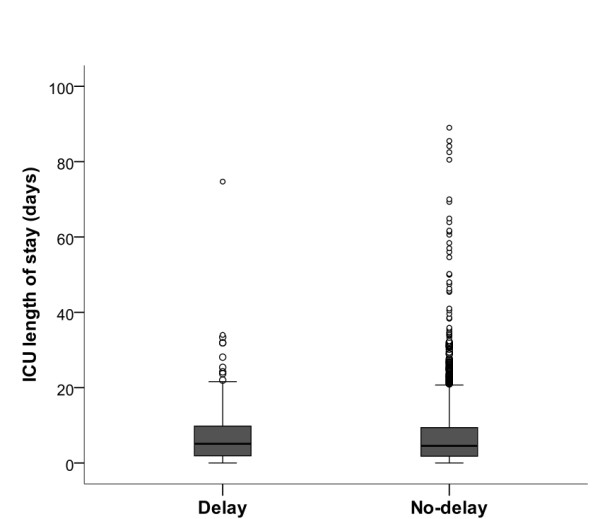
Length of ICU stay. Components: Black line = median; Box margins = 25th and 75th percentile; Whiskers = x1.5 of inter-quartile range (IQR); Circles = outliers (> × 1.5 of IQR).